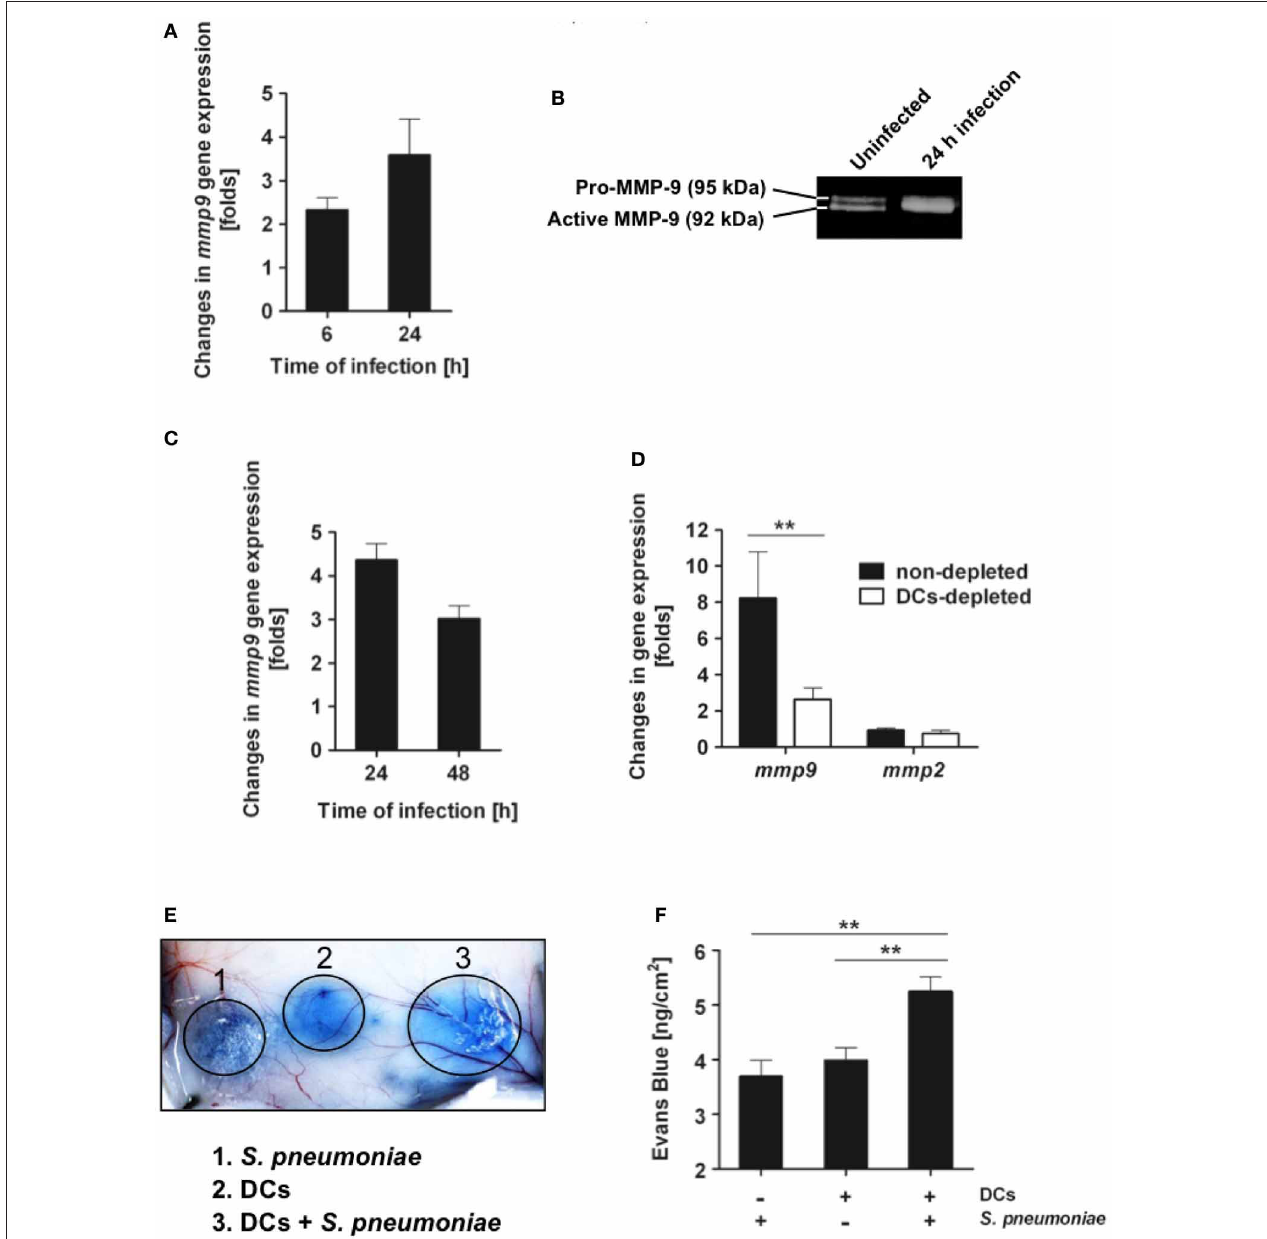
for detection of MMP-9 mRNA. Each bar represents the mean value of three independent experiments. (D) Up-regulation of mmp-9 gene expression in the lungs of DCs-depleted (white bar) or non-depleted (black bar) CD11c-DTR chimera mice at 24h of infection with 1 × 10 8 CFU of S. pneumoniae D39. Each bar represents the mean value of three independent experiments. (E) Vascular permeability induced by the supernatant from either S. pneumoniae (1), DCs (2), or S. pneumoniae -infected DCs (24h postinfection) (3). Supernatant (50 μ l) was intradermally applied into the skin of Evans blue-treated mice and vascular leakage of Evans blue was visualized 1h thereafter. A representative experiment out of three is shown. (F) Quantification of Evans blue leakage in the skin of mice after application of supernatant from S. pneumoniae , DCs or S. pneumoniae -infected DCs (24h postinfection). Each bar represents the mean ± SD of three independent experiments. ∗∗ p < 0 .